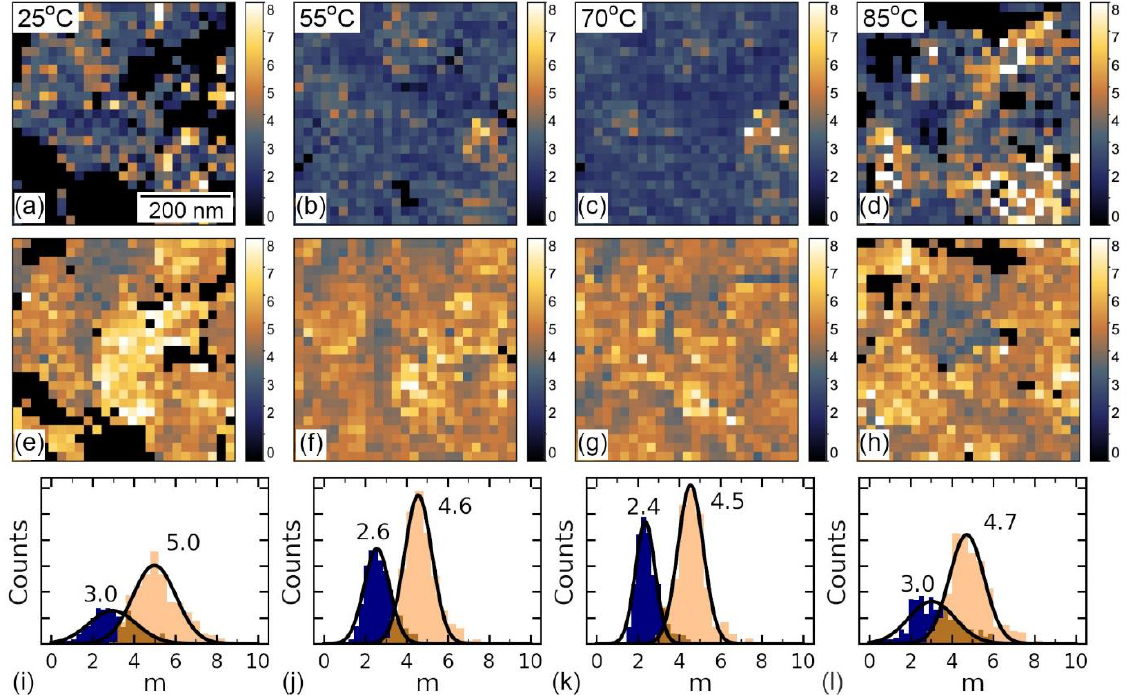
Figure 10. The distribution of power degree m extracted by the fitting of I-V curves from Figure 3 by Equation (2) in ( a – d ) forward and ( e , f ) backward direction of the positive current branch. Black dots denote the region, where the current is small and fit doesn’t coverage. ( i – l ) Respective histograms extracted from ( a – d ) are plotted in blue and from ( e – h ) – in the beige color. In contrast to the curves from the red area from Figure 3m – p, the power degree m in the yellow and blue areas does not show an apparent change after I-V measurements (Fig- ure 10), which shows a similar trap occupation before and after voltage application in these regions. After electron release, traps in yellow and red regions have a similar distri-